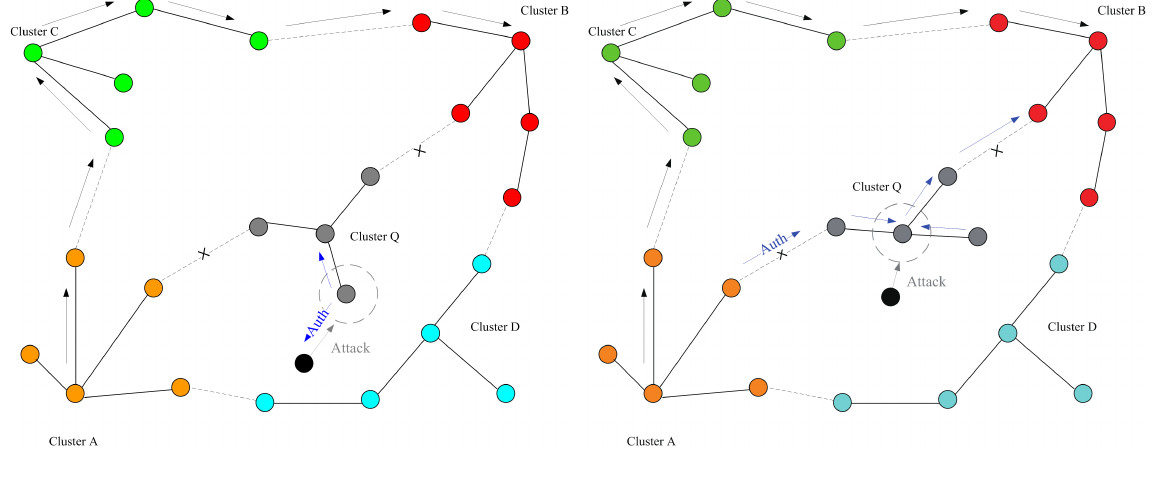
Figure 15. Authentication of quarantined nodes (Case II): a member node (left) and a clusterhead (right).